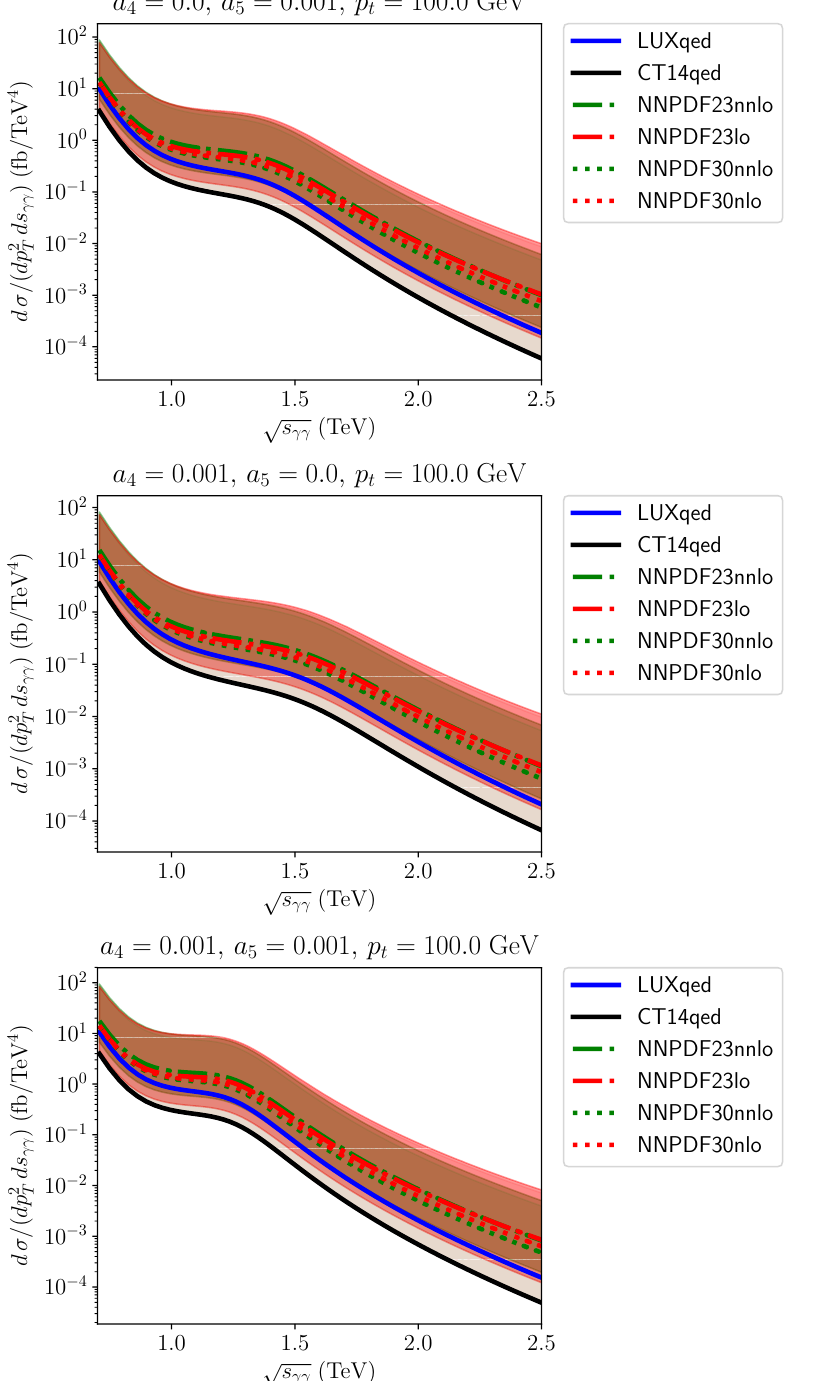
Figure 17 . Same as (cid:12)gure 12, with the NNPDF uncertainty bands. Both protons dissociate in the deeply inelastic regime. (E(cid:11)ective) PDF energy scale (cid:22) 2 = s (cid:13)(cid:13)